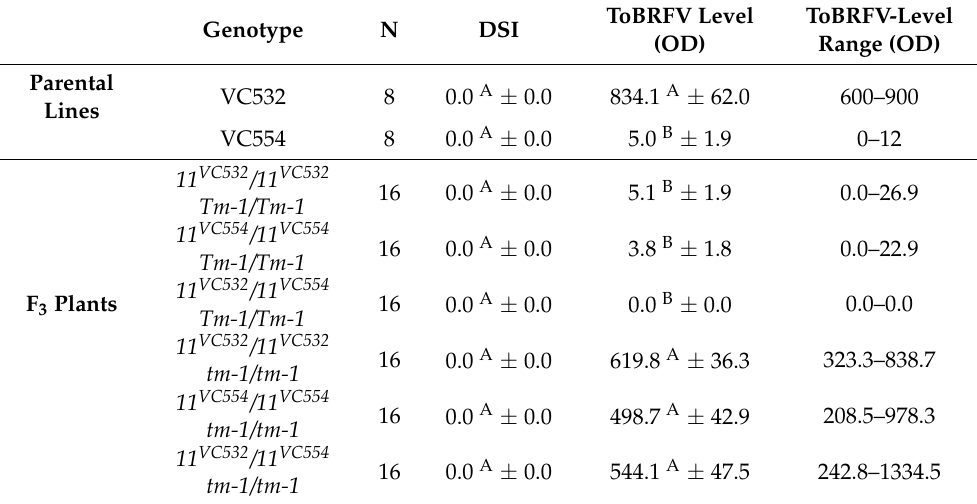
Table 9. Average disease severity index (DSI) and average ToBRFV level and its range in parental lines (upper part of the table) and in F 3 gene combinations inoculated with ToBRFV (lower part of the